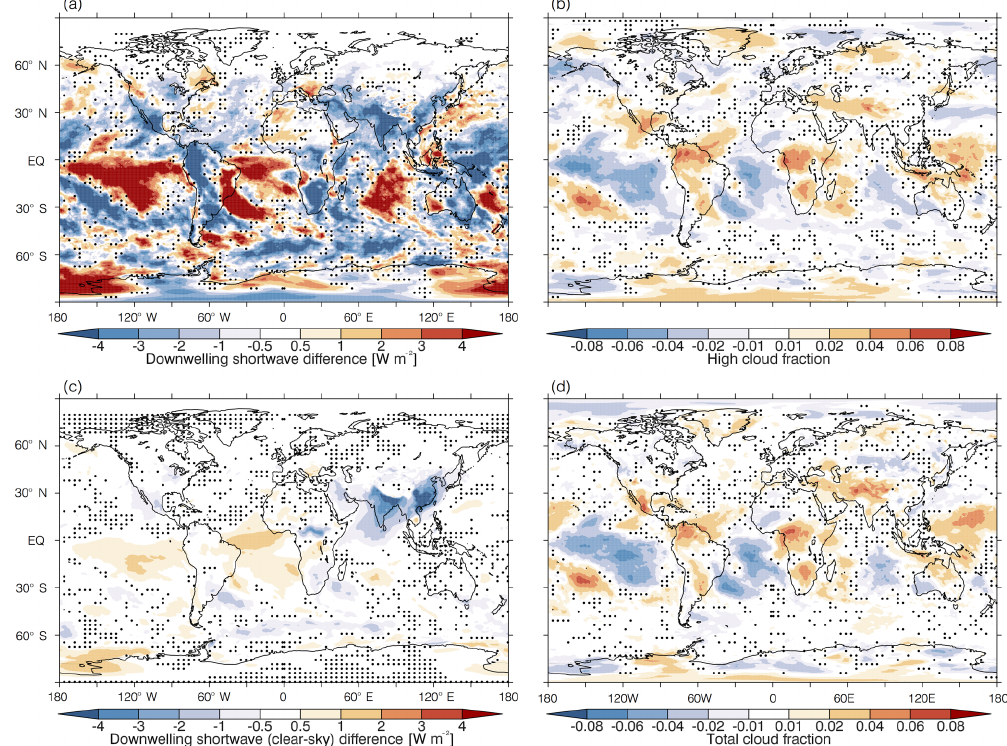
Figure 3. Ensemble mean, (1998–2012) vs. (1979–1993), difference in (a) downwelling short wave at the surface, (b) high cloud fraction, (c) downwelling short wave at the surface (clear sky), and (d) total cloud fraction. Dots indicate where the response is not significant at the 10% level, as calculated using a two-tailed Student’s t test.